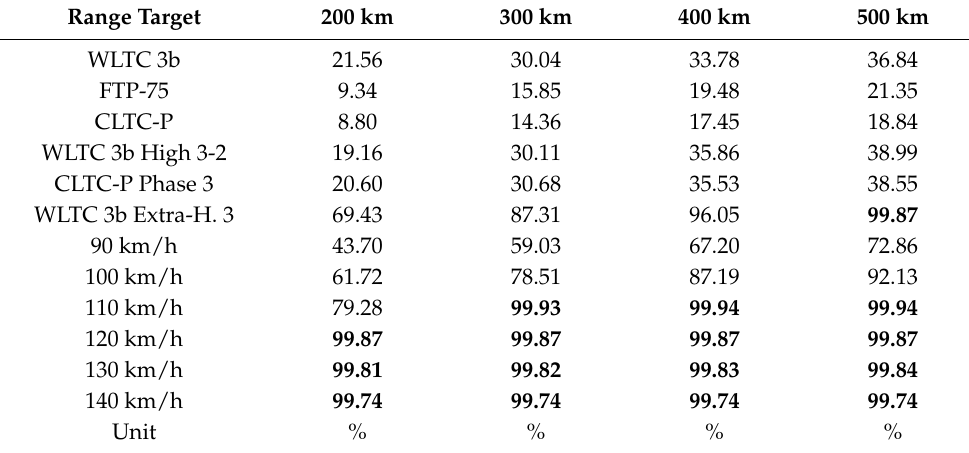
Table A5. REX utilization measures % of total driving time when REX is enabled. Bolded values indicate that REX is engaged once and working constantly, and a range target cannot be obtained. Vehicle mass equals to 1800 kg.